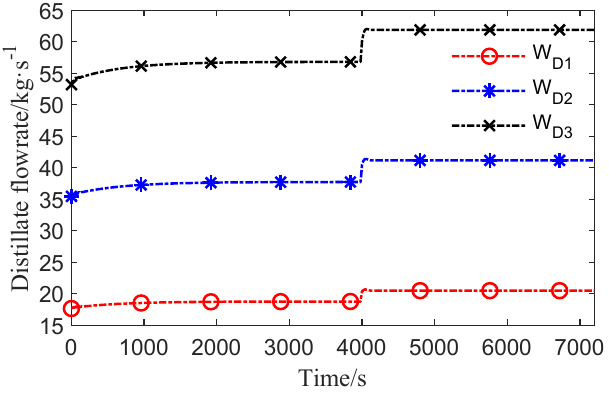
Figure 30. Dynamic of T B 1 , T B 2 , T B 3 for step increase in T steam .